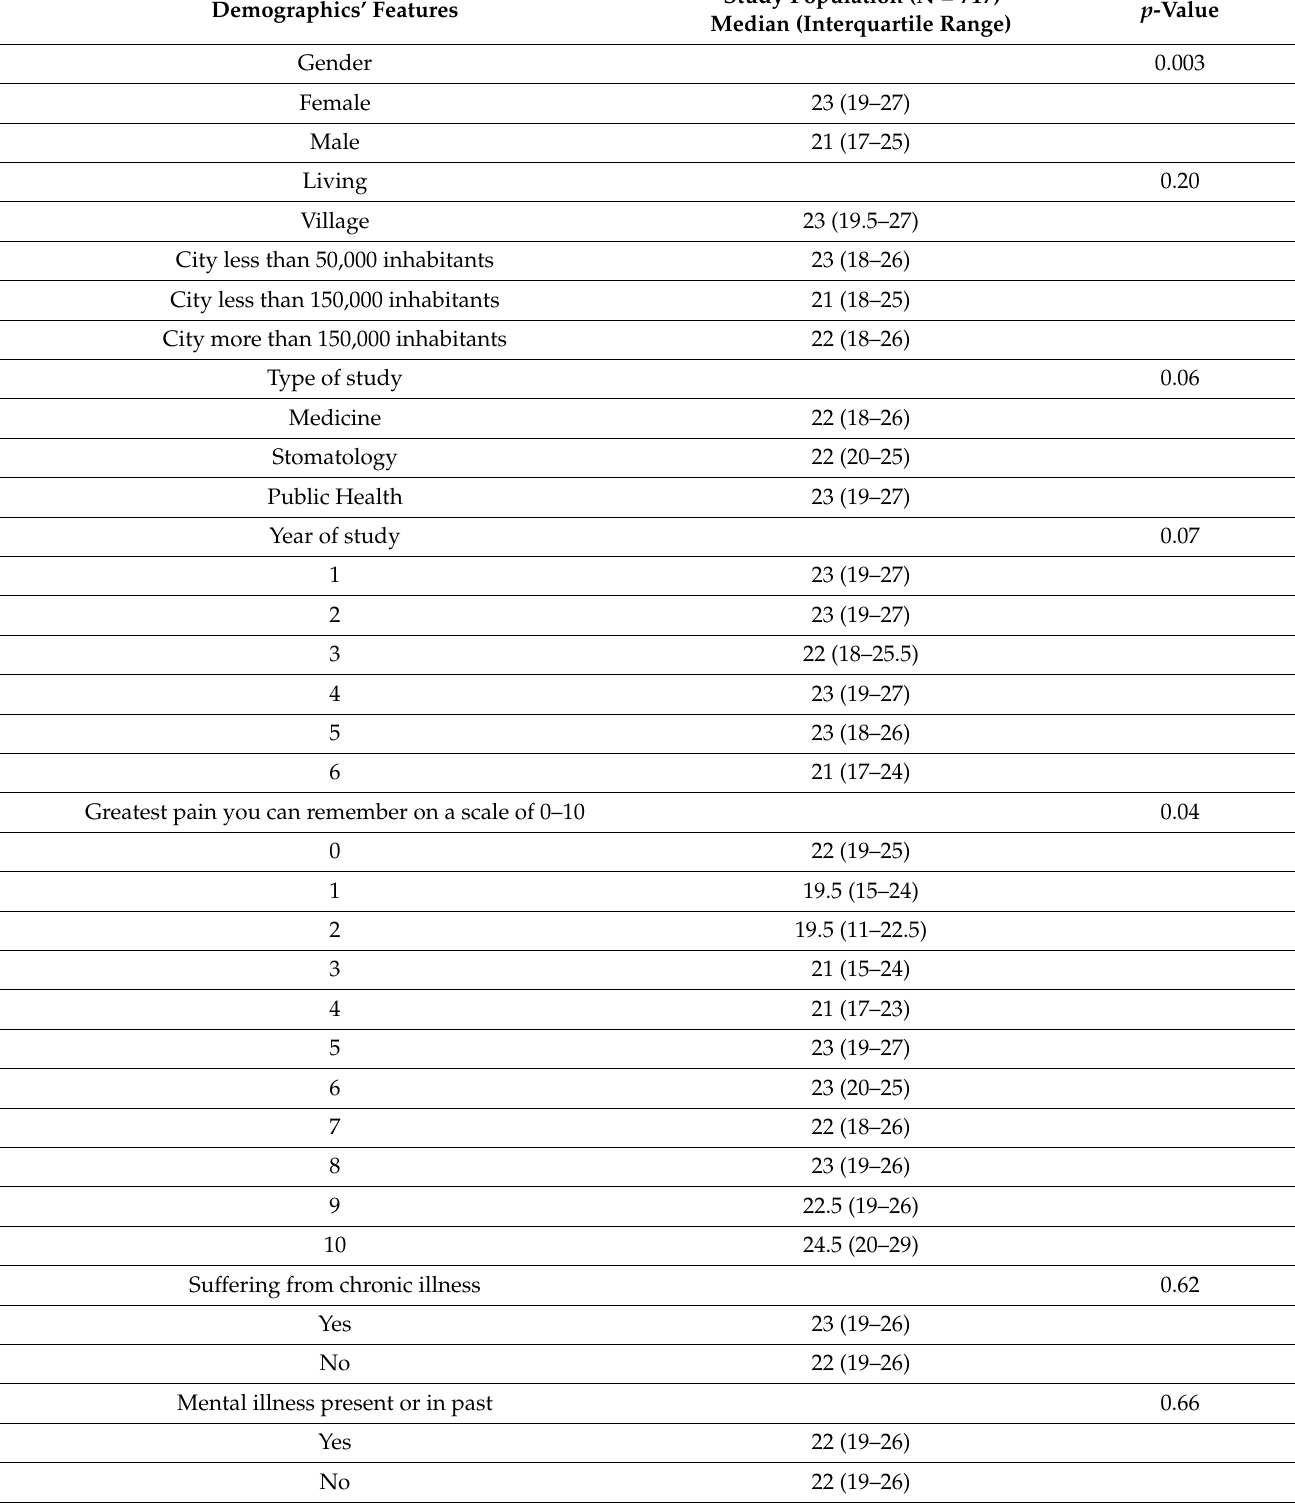
Table 5. Factors associated with overall fear of